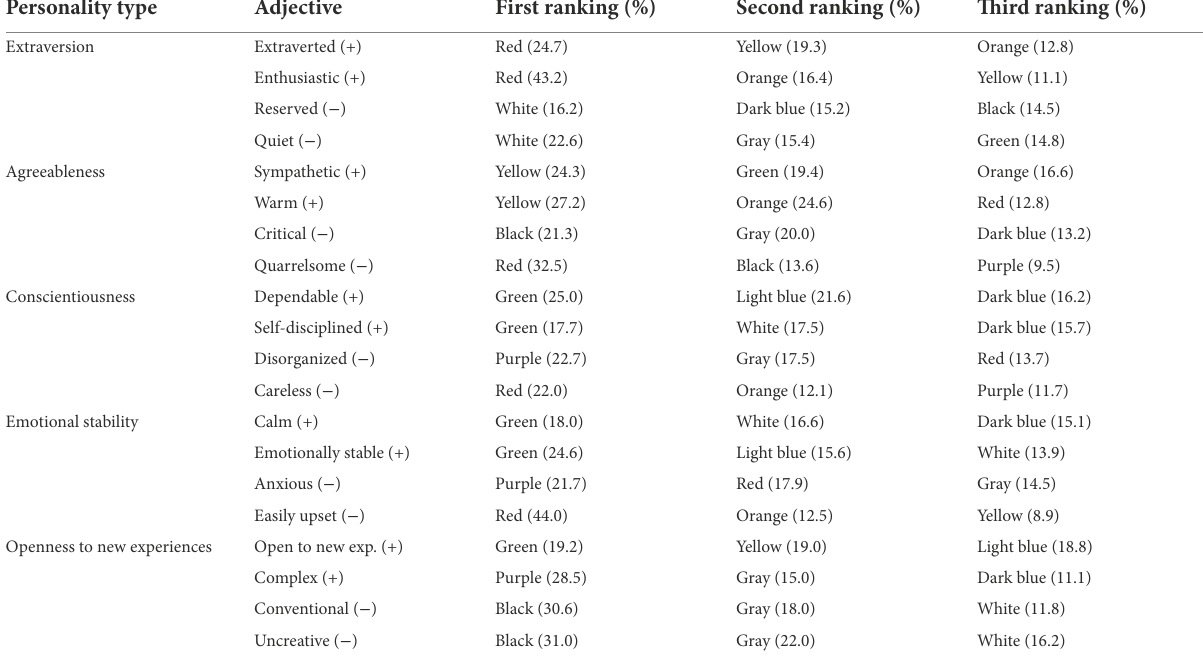
TABLE 1 Colors associated with personality